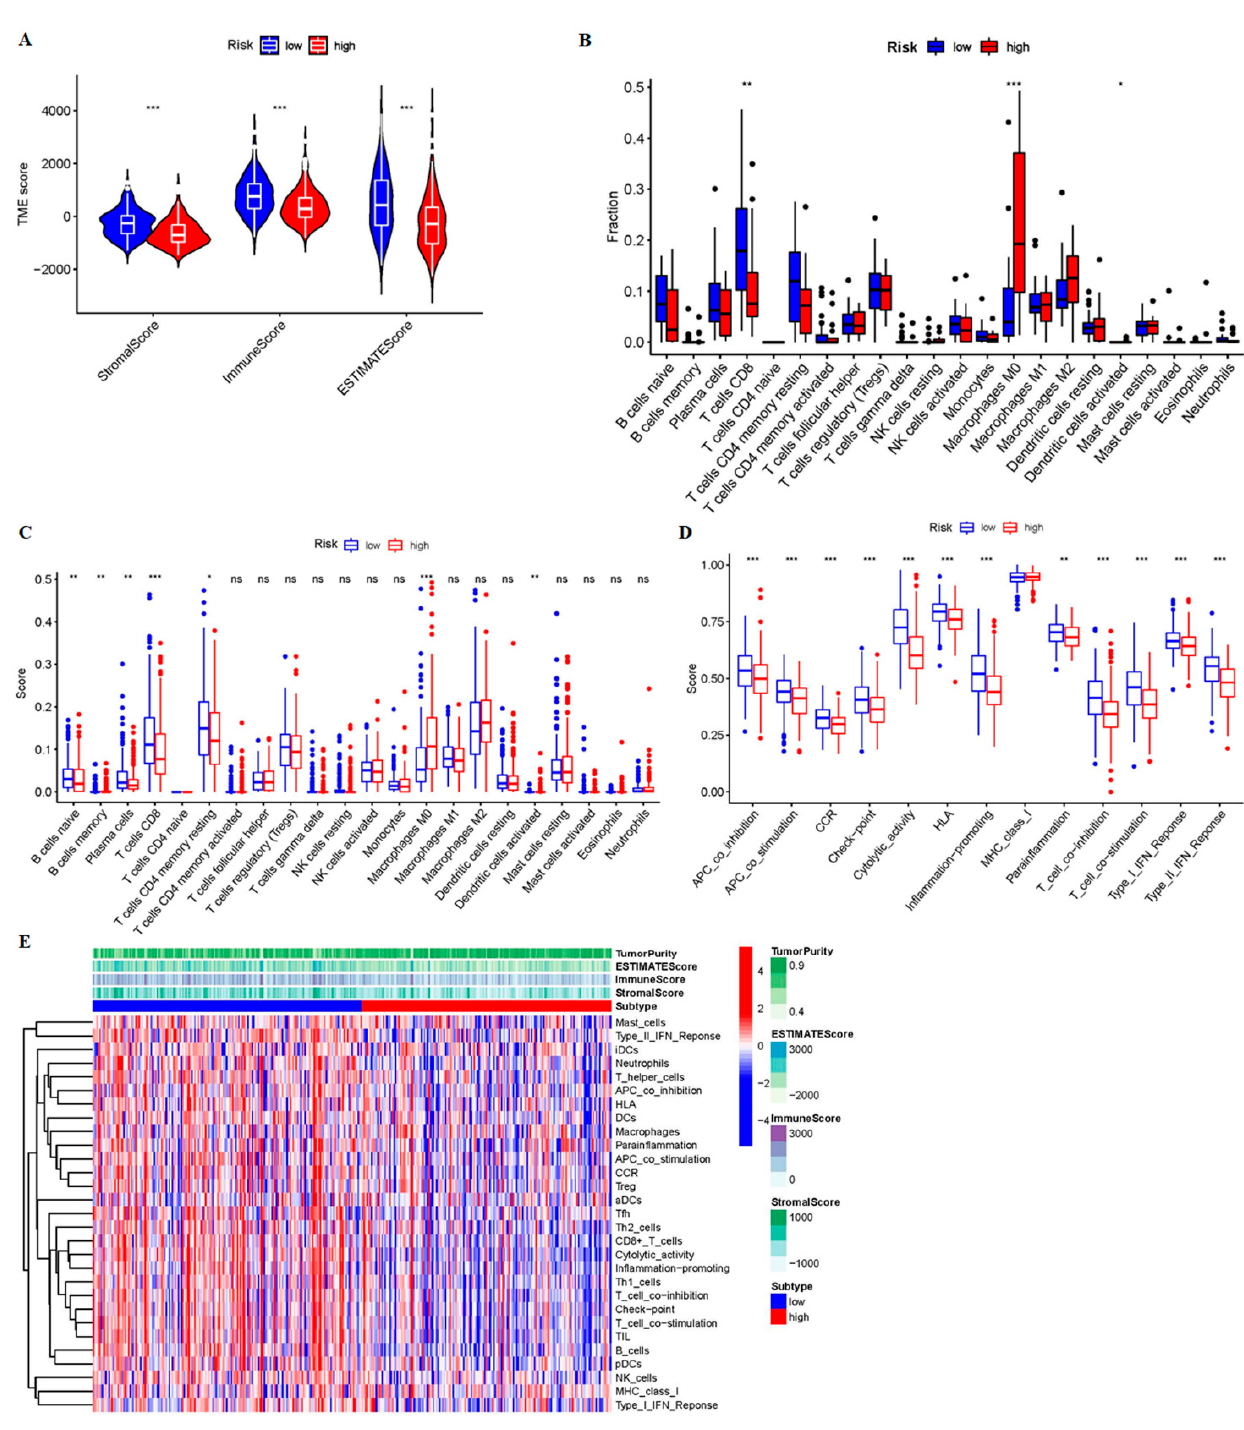
Figure 7. Immune profiles between different risk groups. ( A ) The boxplots of the stroma, immune, and estimate scores of the two groups, and the Wilcoxon test is used for comparison. ( B ) The comparison of immune cell subtypes in the low- and high-risk groups. The differences of ( C ) immune cell infiltration and ( D ) immune function between the two risk groups according to ssGSEA. ( E ) The heatmap summarized stroma, immune, estimate scores, tumor purity, immune cell infiltration, and immune function between the two groups. * p < 0.05, ** p < 0.01, and *** p < 0.001, ns means no significance.